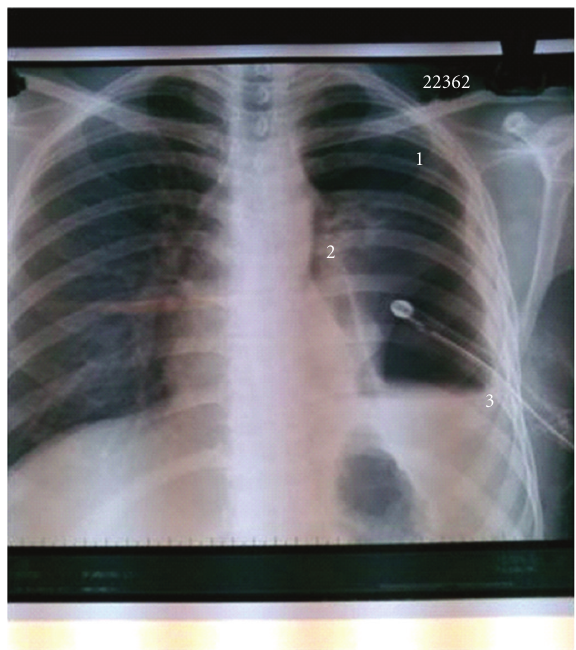
Figure 1: Chest roentgenogram showing massive left pneumotho- rax (1) with collapsed left lung (2). Intercostal drain is seen in situ with residual pyothorax (3).